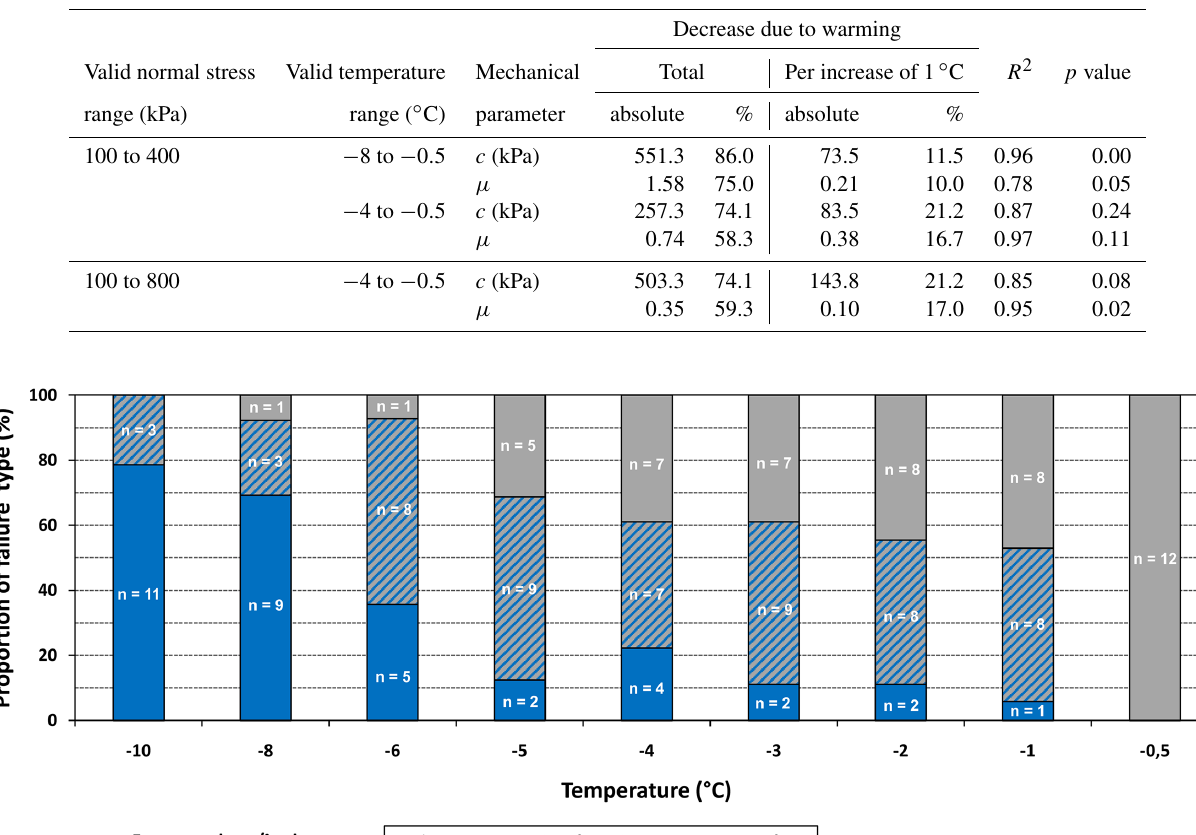
Table 2. Calculated absolute and percentage decrease in cohesion and friction due to warming for various normal stress and temperature ranges.